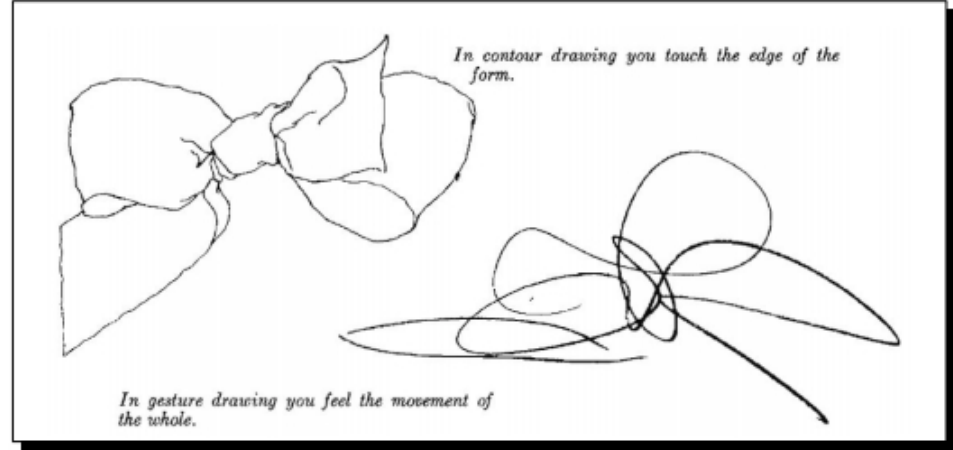
Figure 3. From “The Natural Way to Draw”, by Kimon Nicolaïdes (1941).